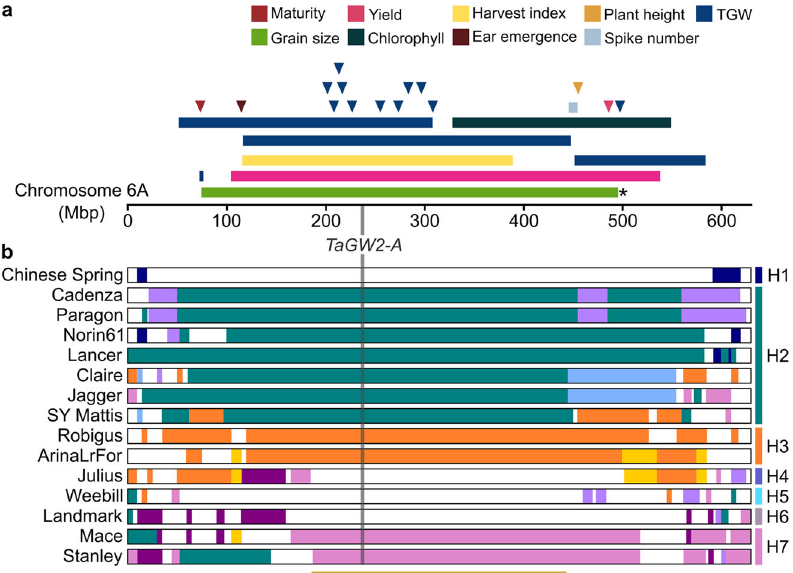
Fig. 3 Haplotypes across the ‘ highly conserved ’ region of chromosome 6A. a Physical positions of productivity-related QTL (rectangles) and GWAS hits (triangles) mapped to the highly conserved region on chromosome 6A (see “ Methods ” ). *; grain-size mapping interval based on UK cultivars Spark and Rialto. b Diagrammatic representation of all haplotype blocks on chromosome 6A in the 15 sequenced cultivars (based on 5-Mbp bin haplotypes; scaled to the longest chromosome 6A). Regions with the same colour at the same position share common haplotypes (except for white regions which are not contained within haplotype blocks). Vertical grey line indicates the position of TaGW2-A (237 Mbp). Labels H1 – H7 indicate haplotype groups based on the minimum haplotype block (beige bar; 187 – 445